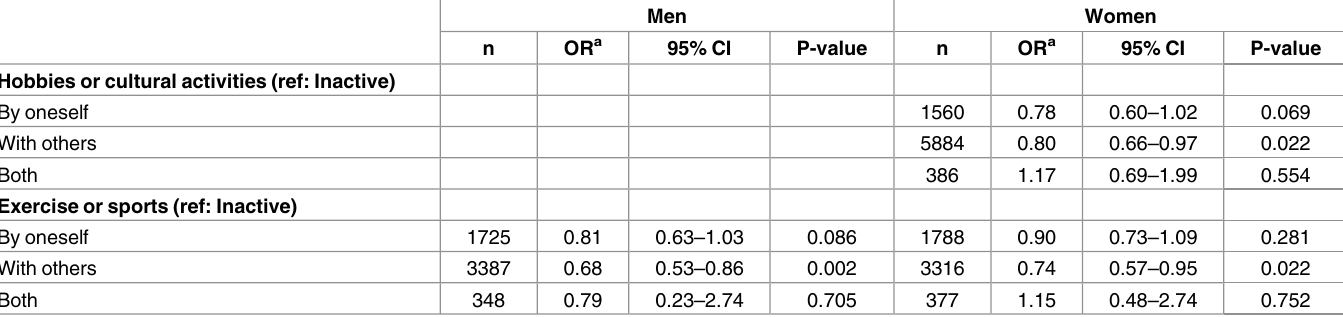
Table 4. Multiple logistic regression analyses investigating the relationships between social aspects of activities and difficulties in